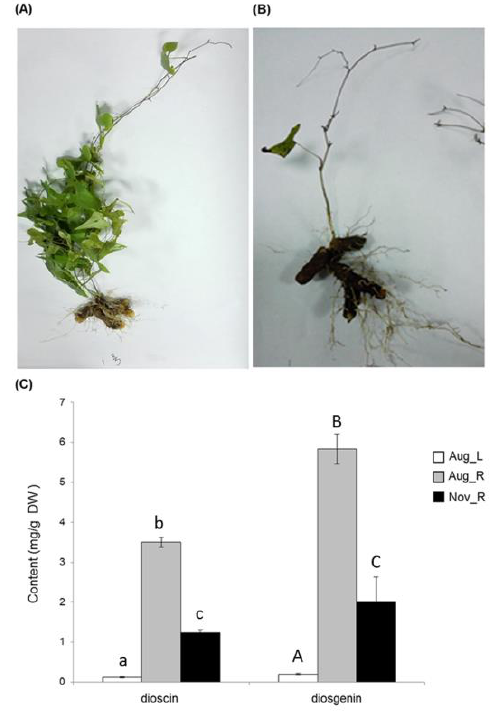
Figure 2. Phytochemical analysis of the leaf and rhizome tissues of D. zingiberensis . (( A ) and ( B )), representative pictures are shown for the D. zingiberensis plants collected in August ( A ) and November ( B ) of 2015; ( C ), the content of diosgenin and dioscin in the different plant parts, including the leaves harvested in August (Aug_L), the rhizomes harvested in August (Aug_R), and the rhizomes harvested in November (Nov_R). Two biological replicates were included for this experiment. Different letters on the bar indicate a significant difference at p < 0.05 based on generalized linear models with Bonferroni multicomparison